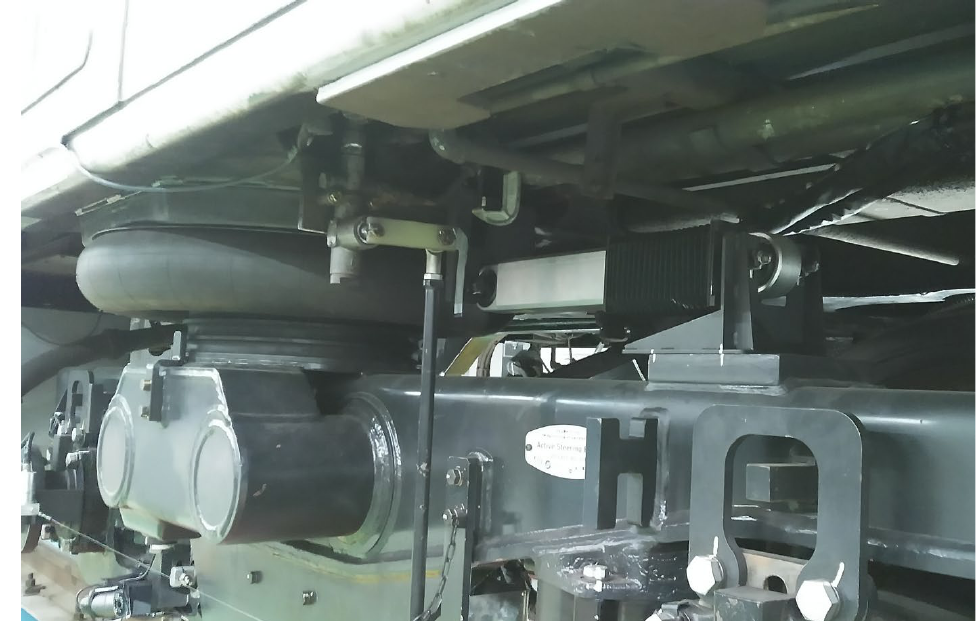
Figure 14. Curvature sensor installed in the test vehicle.